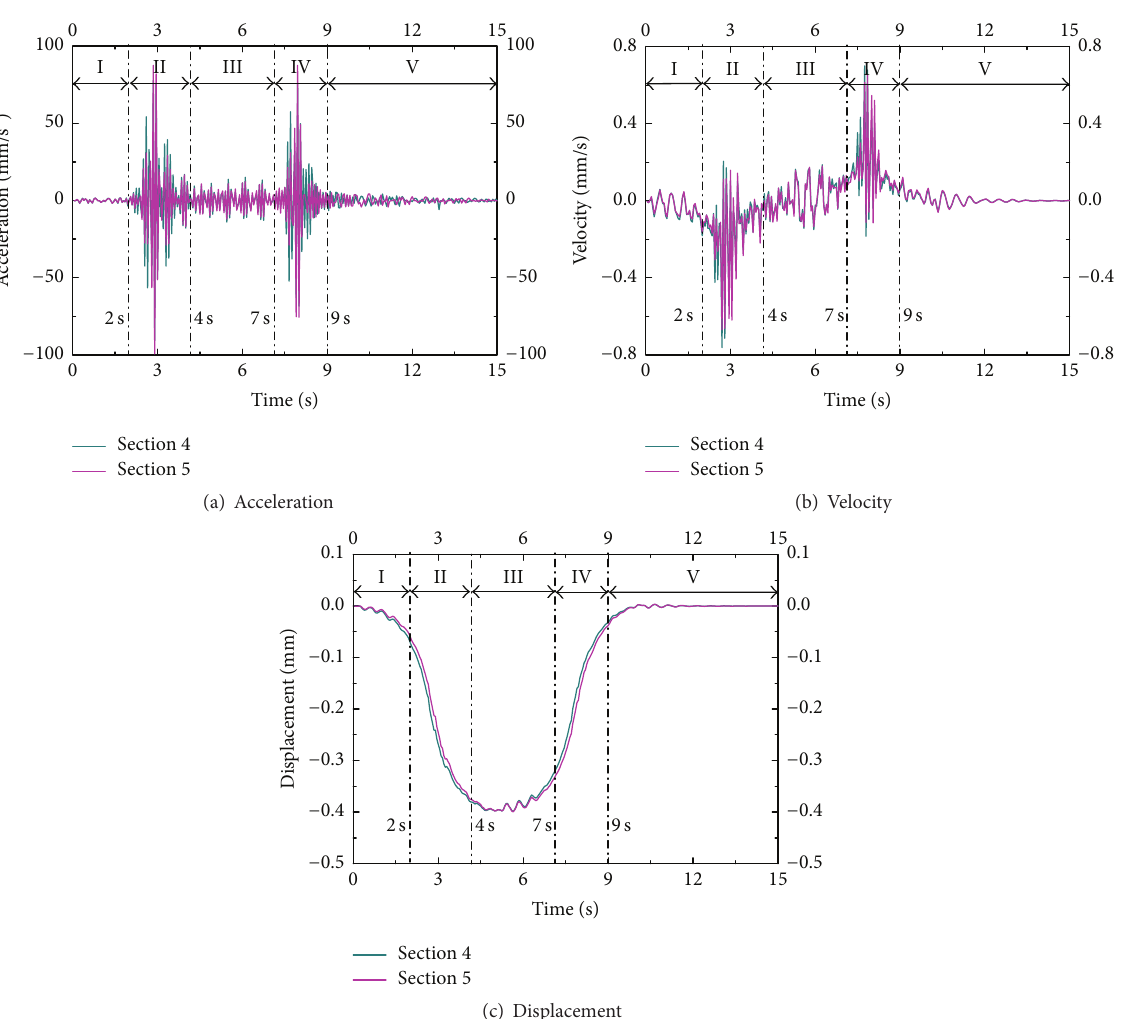
Figure 12: Time history of the (a) acceleration, (b) velocity, and (c) displacement at point D.